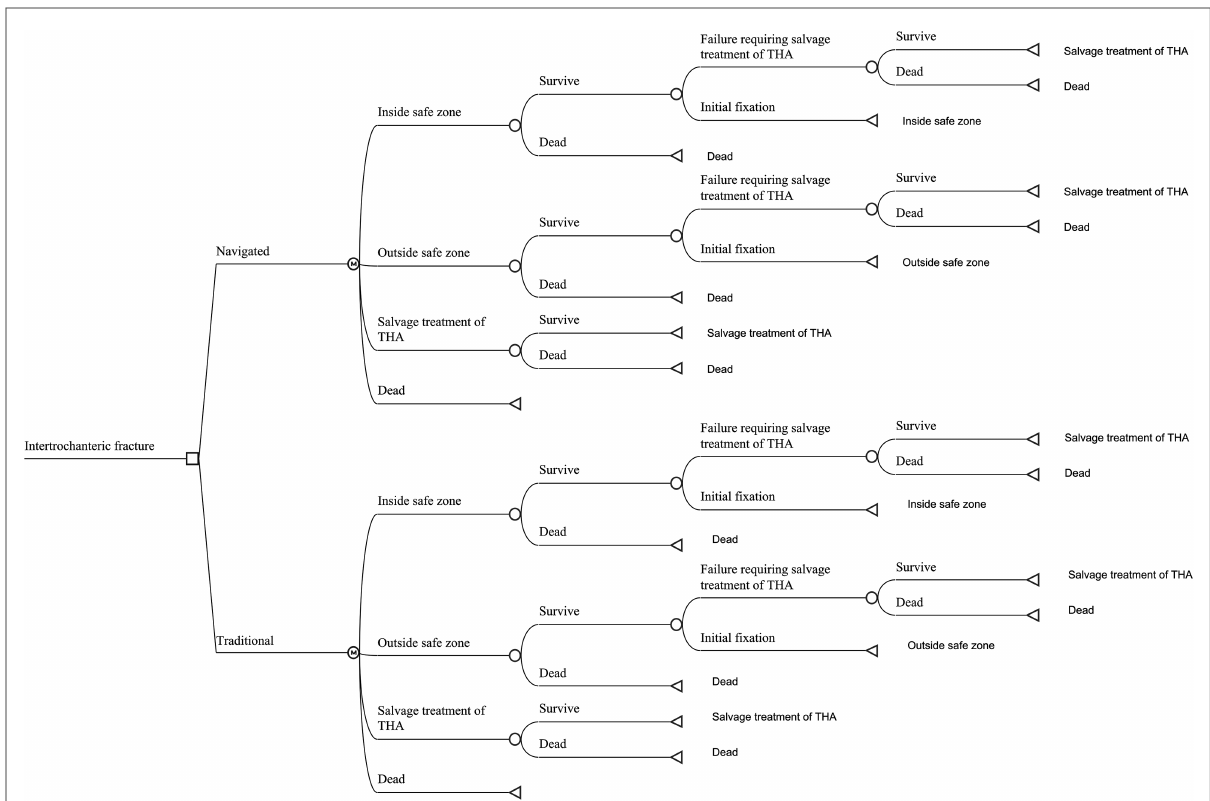
FIGURE 1 The markov model for patients with intertrochanteric hip fractures. Each patient received in-tramedullary nailing (IMN), either with navigated or traditional assistance. The patient received the IMN procedure and the lag screw was possibly inside or outside the safe zone. If a patient survived the perioperative period, that patient would stay in the status of successful initial fi xation with the lag screw inside or outside the safe zone, experience IMN failure requiring salvage treatment of total hip arthroplasty (THA) or die from other